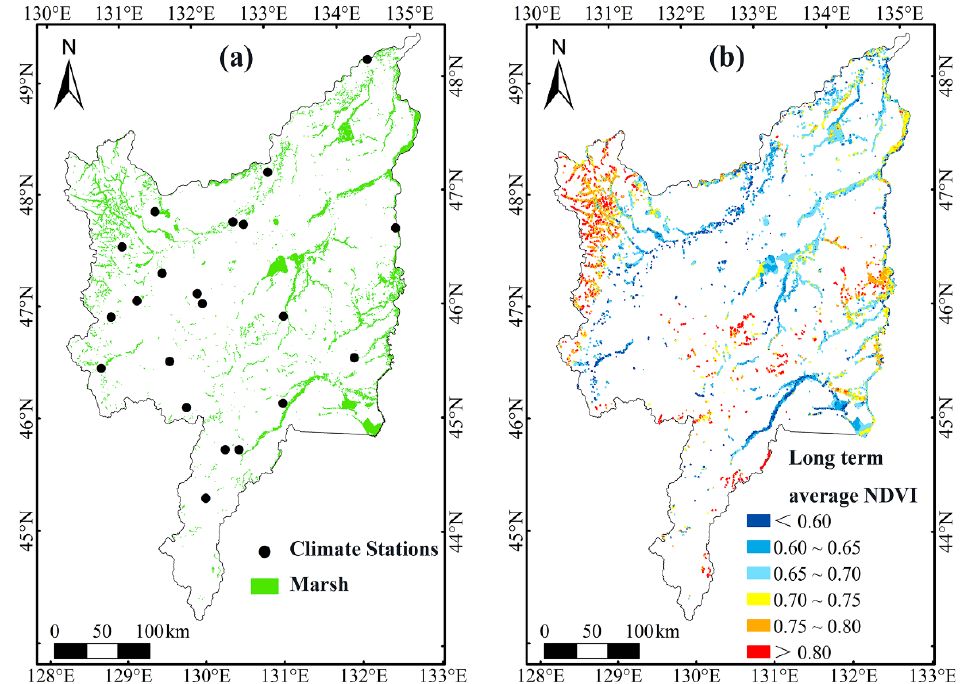
Figure 1. Spatial distribution of ( a ) marsh wetlands and ( b ) long-term average growing season NDVI of unchanged marsh vegetation in Sanjiang Plain from2000 to 2020.